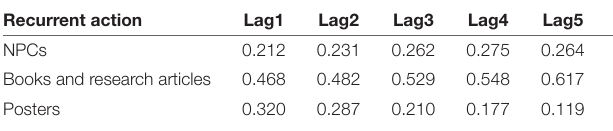
TABLE 1 | Proportional means of recurrence points across Lags 1-5 and instructional materials. Recurrent action